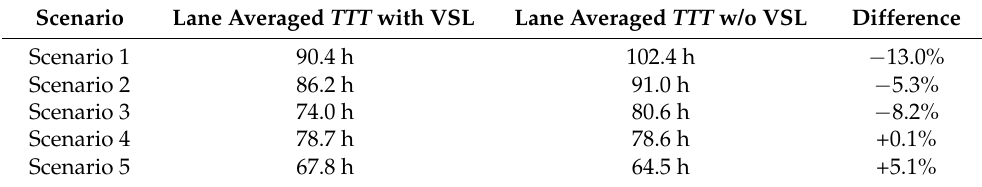
Table 2. Macroscopic simulation results.